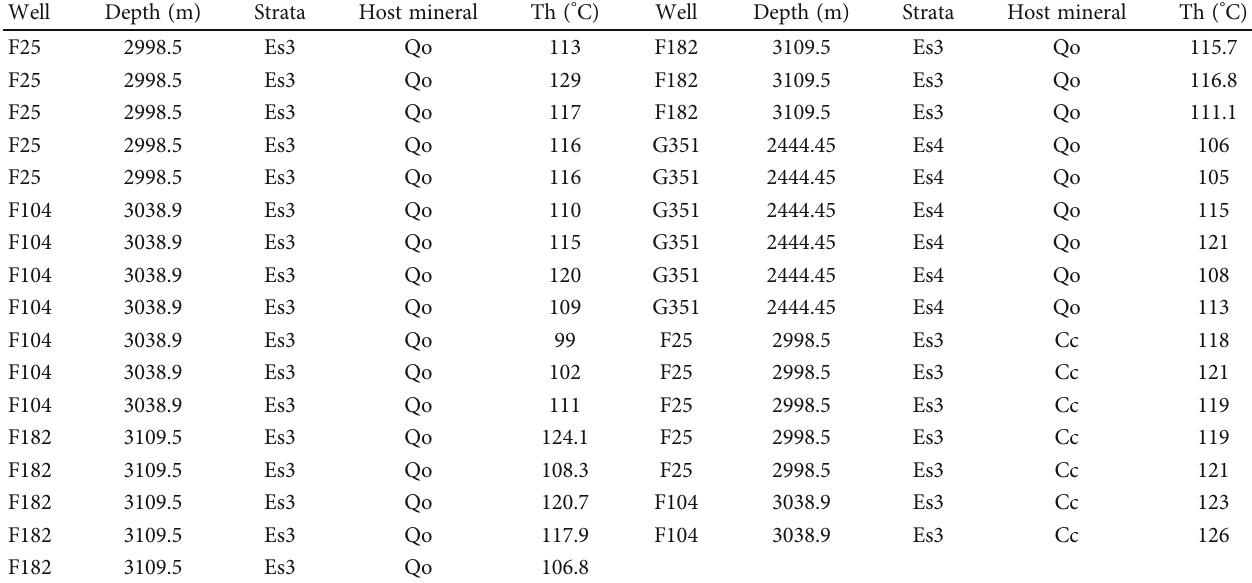
Table 2: Microthermometric data of fl uid inclusions in the authigenic